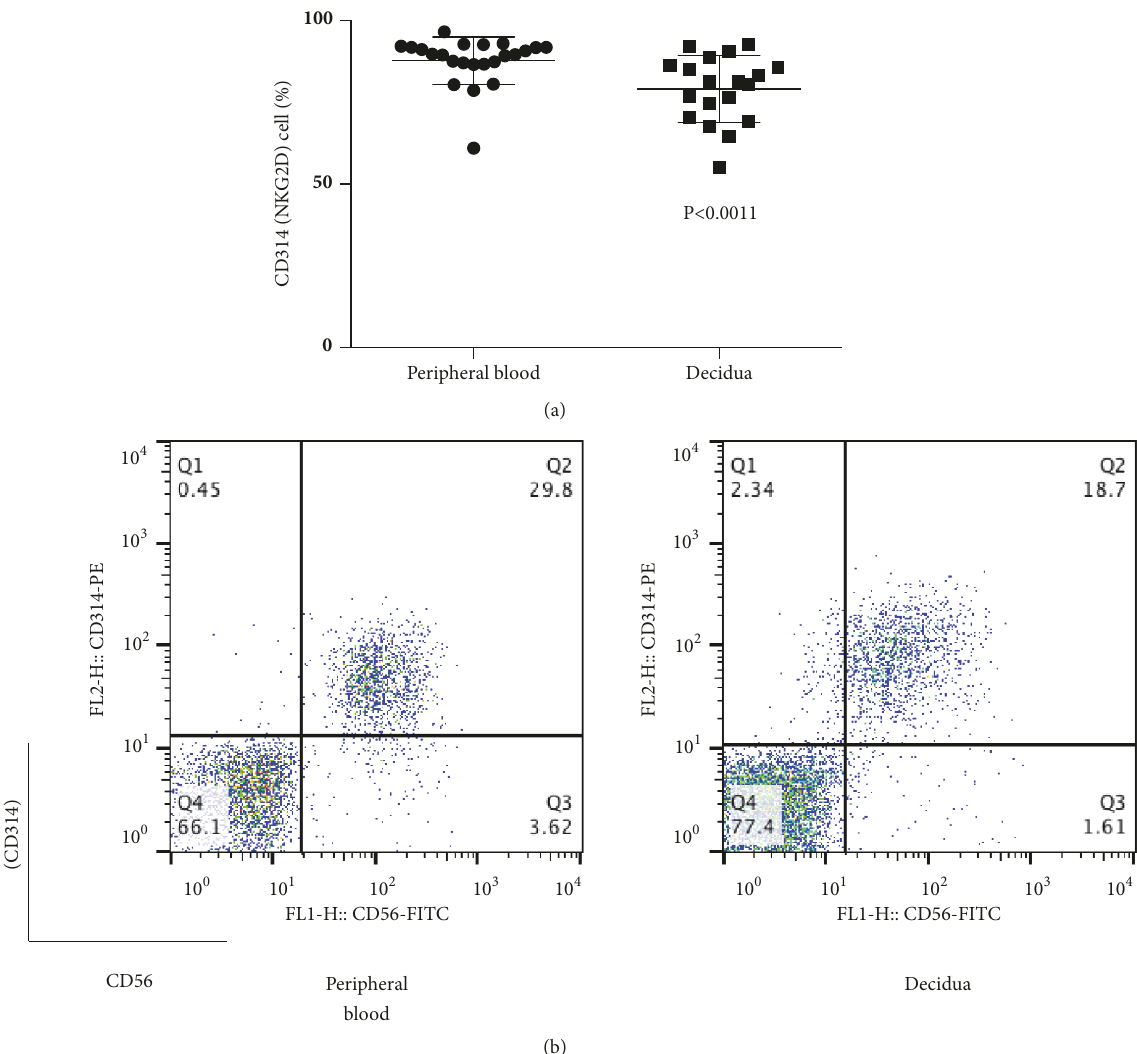
Figure 3: (a) Percentage of CD314 (NKG2D)+ cells among CD56+CD3 − cells at term pregnancy in peripheral blood and decidua. The percentages of CD314 (NKG2D)+ lymphocytes in decidua were lower than those in peripheral blood. (b) Representative dot plot analysis of CD314 (NKG2D)+ cells among CD56+3- lymphocytes taken from term pregnancy by flow cytometry. The gate was set around the CD3- lymphocytes to analyze the CD314+CD56+ NK